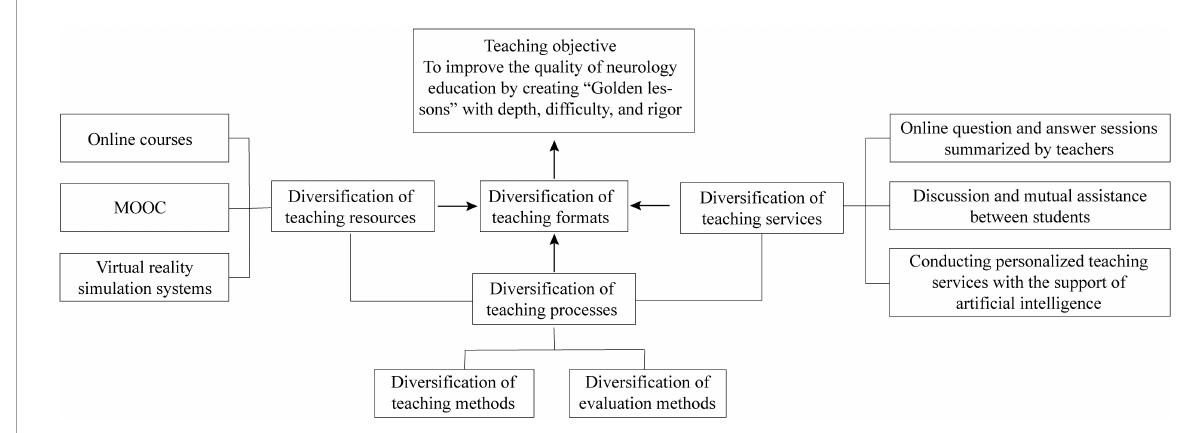
FIGURE1 Construction of a diverse online neurology teaching method during the COVID-19